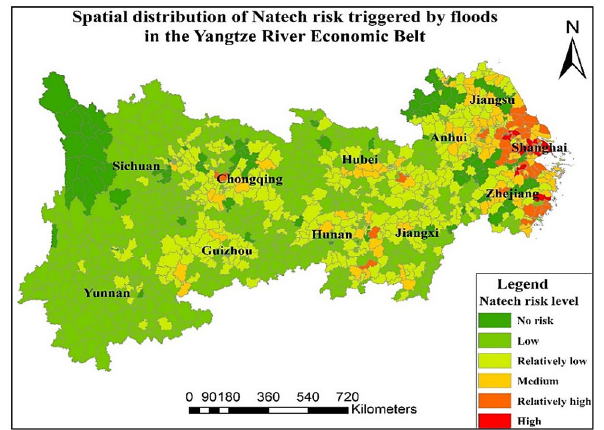
Figure 3. Distribution of Natech risk triggered by floods in the YREB. Map is produced using ArcGIS 10.2 (http:// www. esri. com/ softw are/ arcgis/ arcgis- for- deskt op).